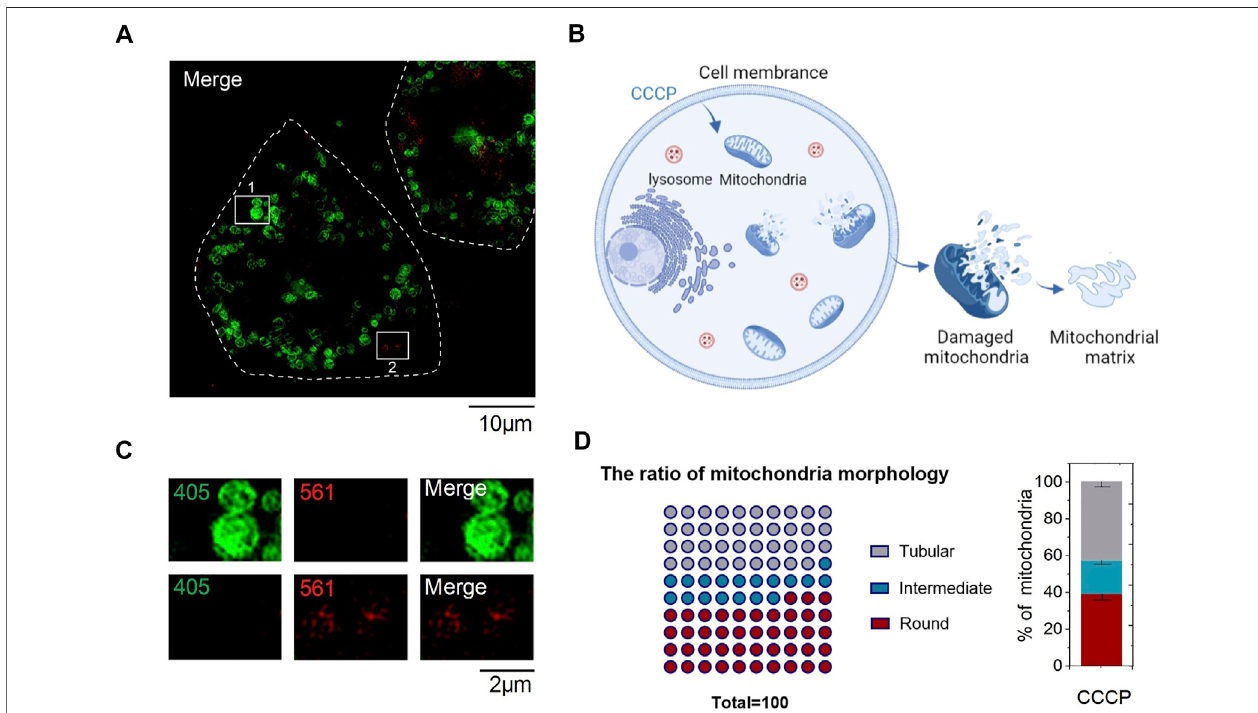
FIGURE 4 | Staining characteristics of CPE in CCCP-treated HeLa cells. (A) CCCP-treated HeLa cells. (B) Sketch map of staining characteristics of CPE in HeLa cells after CCCP treatment. (C) Enlarged images oftheindicated regionsin (A) . (D) Quantitative analysisformitochondrial morphologyofHeLacellstreatedafter CCCP.